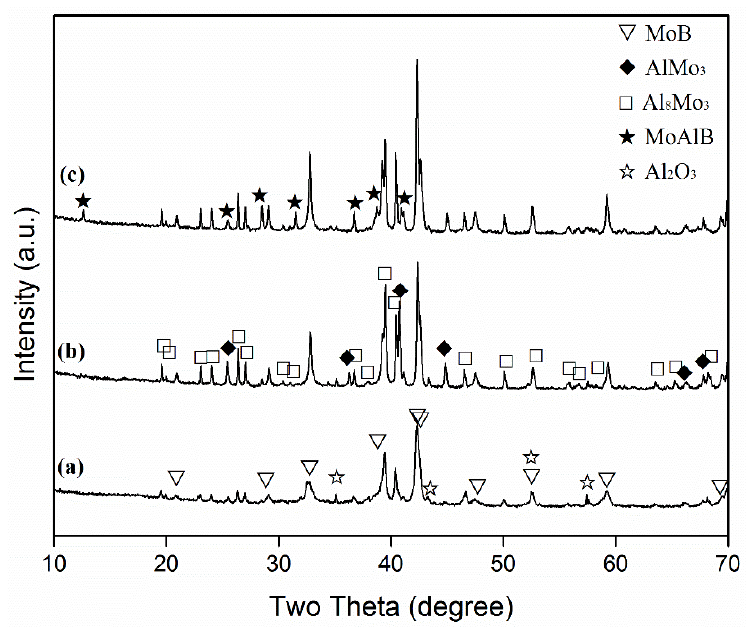
Figure 1. XRD spectra of the samples with the stoichiometric composition after 6 h at ( a ) 850, ( b ) 900 and ( c ) 950 °C.